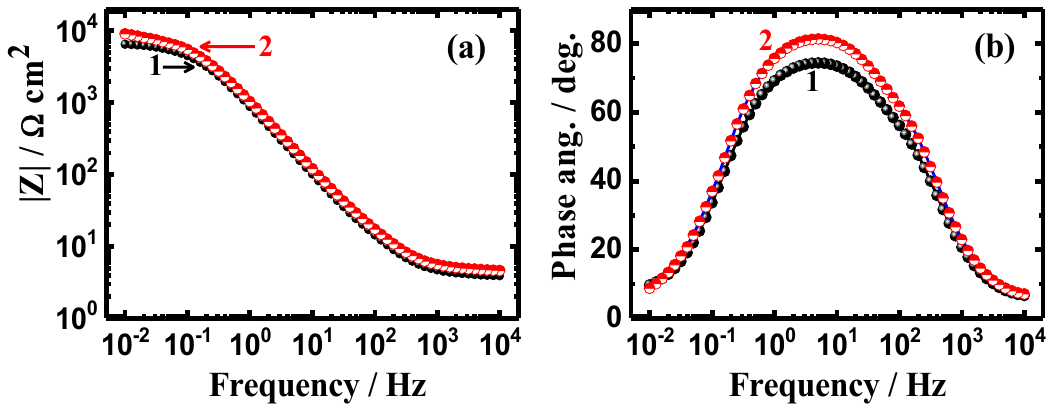
Figure 9. Change of ( a ) | Z | and ( b ) Φ with frequency plots obtained for (1) API-2H steel and (2) 75%Cr 3 C 2 − 25%NiCr coated API-2H steel after their immersion in 4% NaCl solution for 24 h.